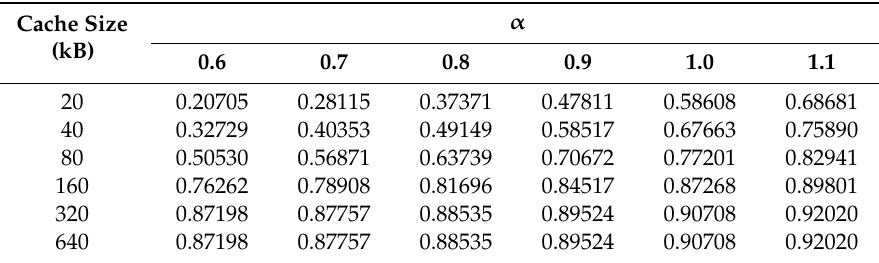
Table 2. Cache hit ratio in the traces generated using α